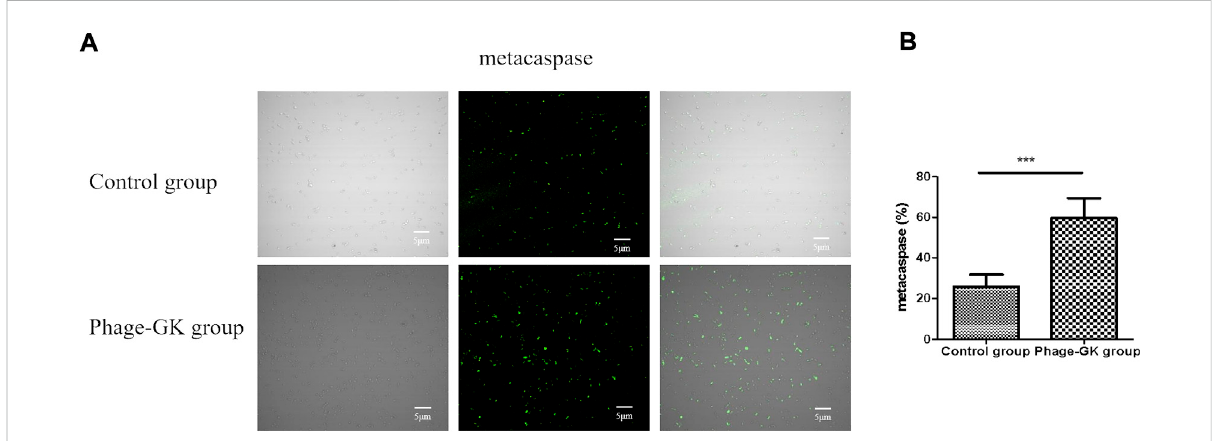
FIGURE 6 Effects of PG treatment on metacaspase activation. (A) Confocal laser scanning microscopy to evaluate the effects of PG treatment on metacaspase activation in S. globosa cells of the study and control groups as observed by staining with CaspACE FITC-VAD-FMK. DIC, differential inference contrast. (B) Flow cytometry was used to detect the metacaspase activation. *** p < 0.001 indicate statistical signi fi cance.